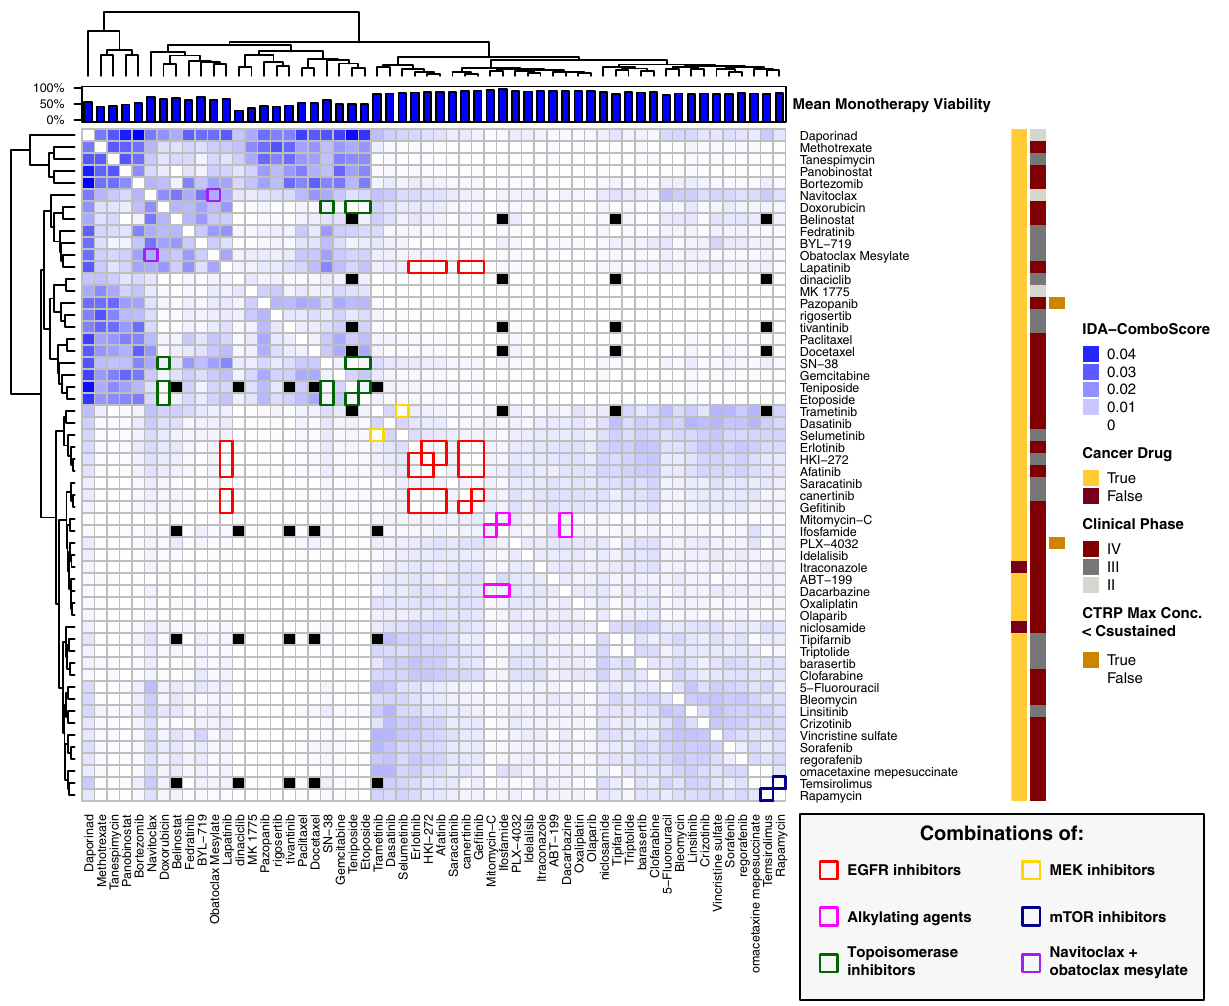
Fig. 5 Top IDAcomboscore predictions for late-stage clinical drugs in CTRPv2. IDAcomboscores were calculated for all two-drug combinations of late- stage clinical drugs in CTRPv2 using all available cell lines for each drug combination. Darker blue squares represent higher comboscores and, therefore, greater predicted drug combination ef fi cacies relative to the constituent monotherapies. Black boxes represent missing values, where ef fi cacies could not be predicted for a combination. The fi rst bar, farthest left on the right side of the heatmap, indicates whether or not that drug is currently used for cancer treatment, the second bar indicates what stage of clinical trials that drug has reached, and the third bar indicates if the known Csustained concentration for the drug was higher than the maximum tested concentration in CTRPv2 such that predictions had to be made with a lower than clinical concentration. The barplot on top of the heatmap indicates the average viability achieved using that drug as a monotherapy (full bar indicates 100% viability). Drugs that were not predicted to combine well with any other drugs (i.e. with a comboscore < 0.004) were excluded from this plot to improve readability, but a full heatmap with all late-stage clinical drugs can be found in the “ IDACombo Paper ” project on OSF (see “ Methods ” section). Colored outlines are used to highlight certain combinations according to the “ Combinations of ” legend in the bottom right. Source data are provided as a Source Data fi